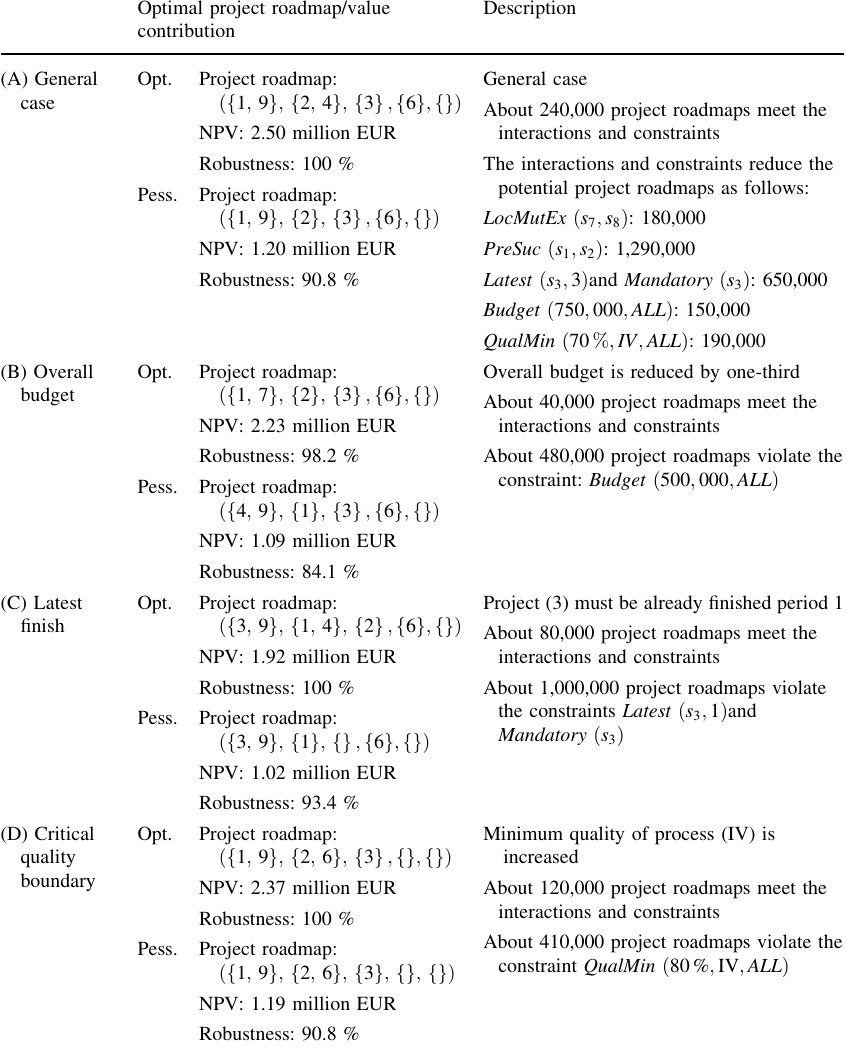
Table 7 Optimal project roadmaps from the scenario analysis Optimal project roadmap/value